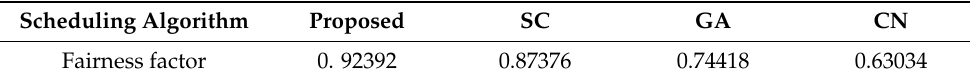
Table 3. Comparison of equity factors (SNR = 20 dB, k =